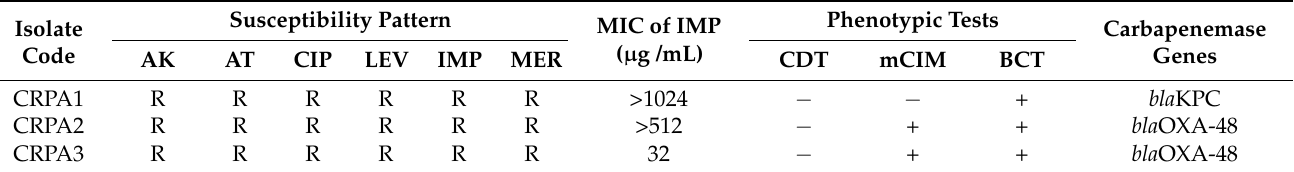
Table 1. Summary for susceptibility pattern, MIC, phenotypic and genotypic detection of CPs P. aeruginosa isolates.